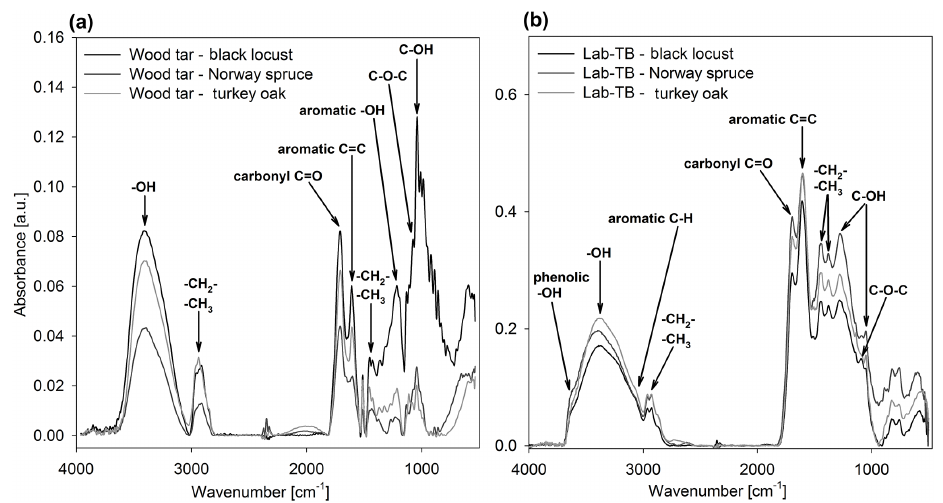
Figure 2. FT-IR spectra of (a) wood tars and (b) laboratory-generated TBs (Lab-TBs) produced from different wood species.